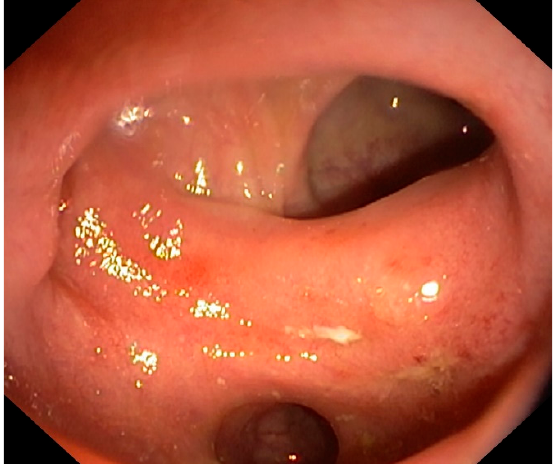
Figure 1. A 68-year-old female underwent a colonoscopy due to bloody diarrhea. Endoscopic ap- pearance shows hyperemia and erosions on the colonic folds and the interdiverticular mucosa, with complete sparing of the diverticula. These lesions can be classified as type B